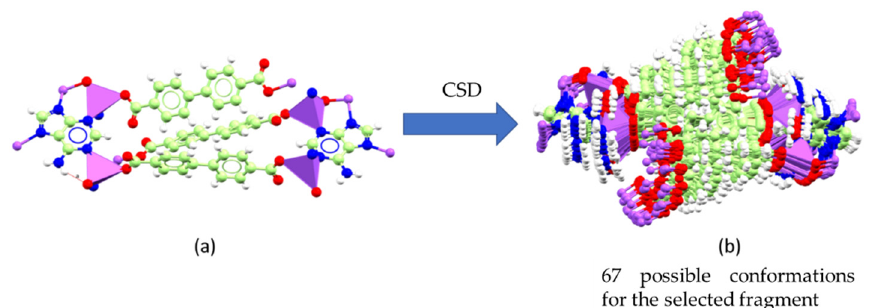
Figure 6. ( a ) BioMOF-100 repeating fragment using as a 3D input model for the generation of conform- ers. ( b ) Set of the 67 conformers generated from the replay subunit of bioMOF-100 (CCDC 833315). In the figure, Zn (II) ions are represented in purple color, N atoms in blue, C atoms in green, O atoms in red, and H atoms are blank/white.